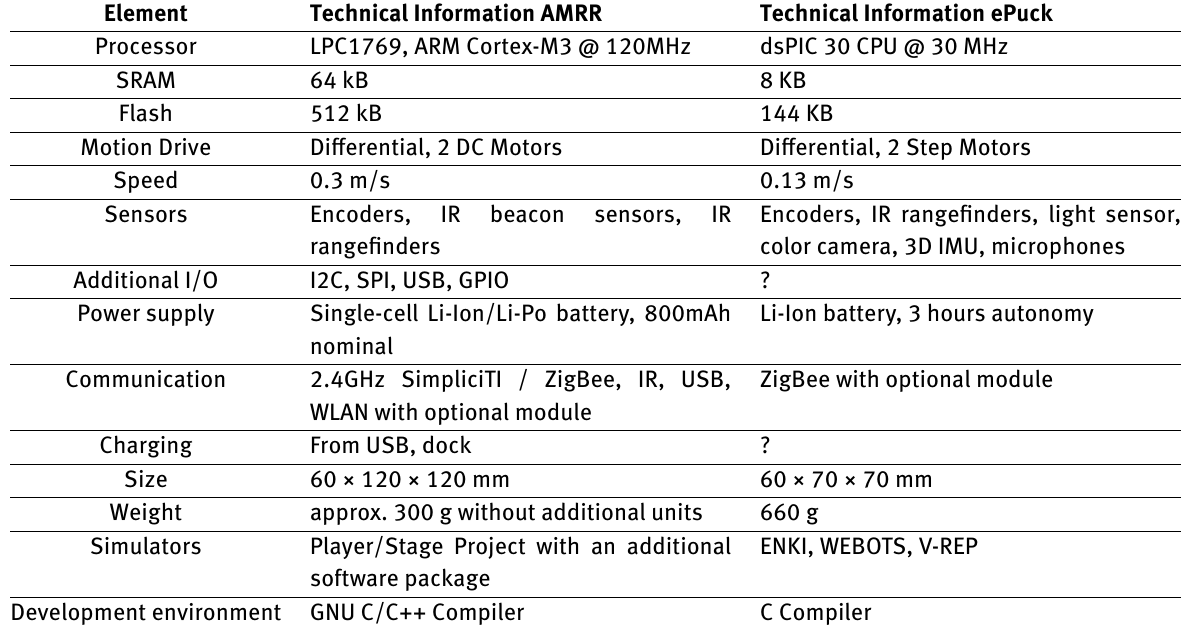
Table 1: Technical specification of the autonomous mobile research robot (AMRR)